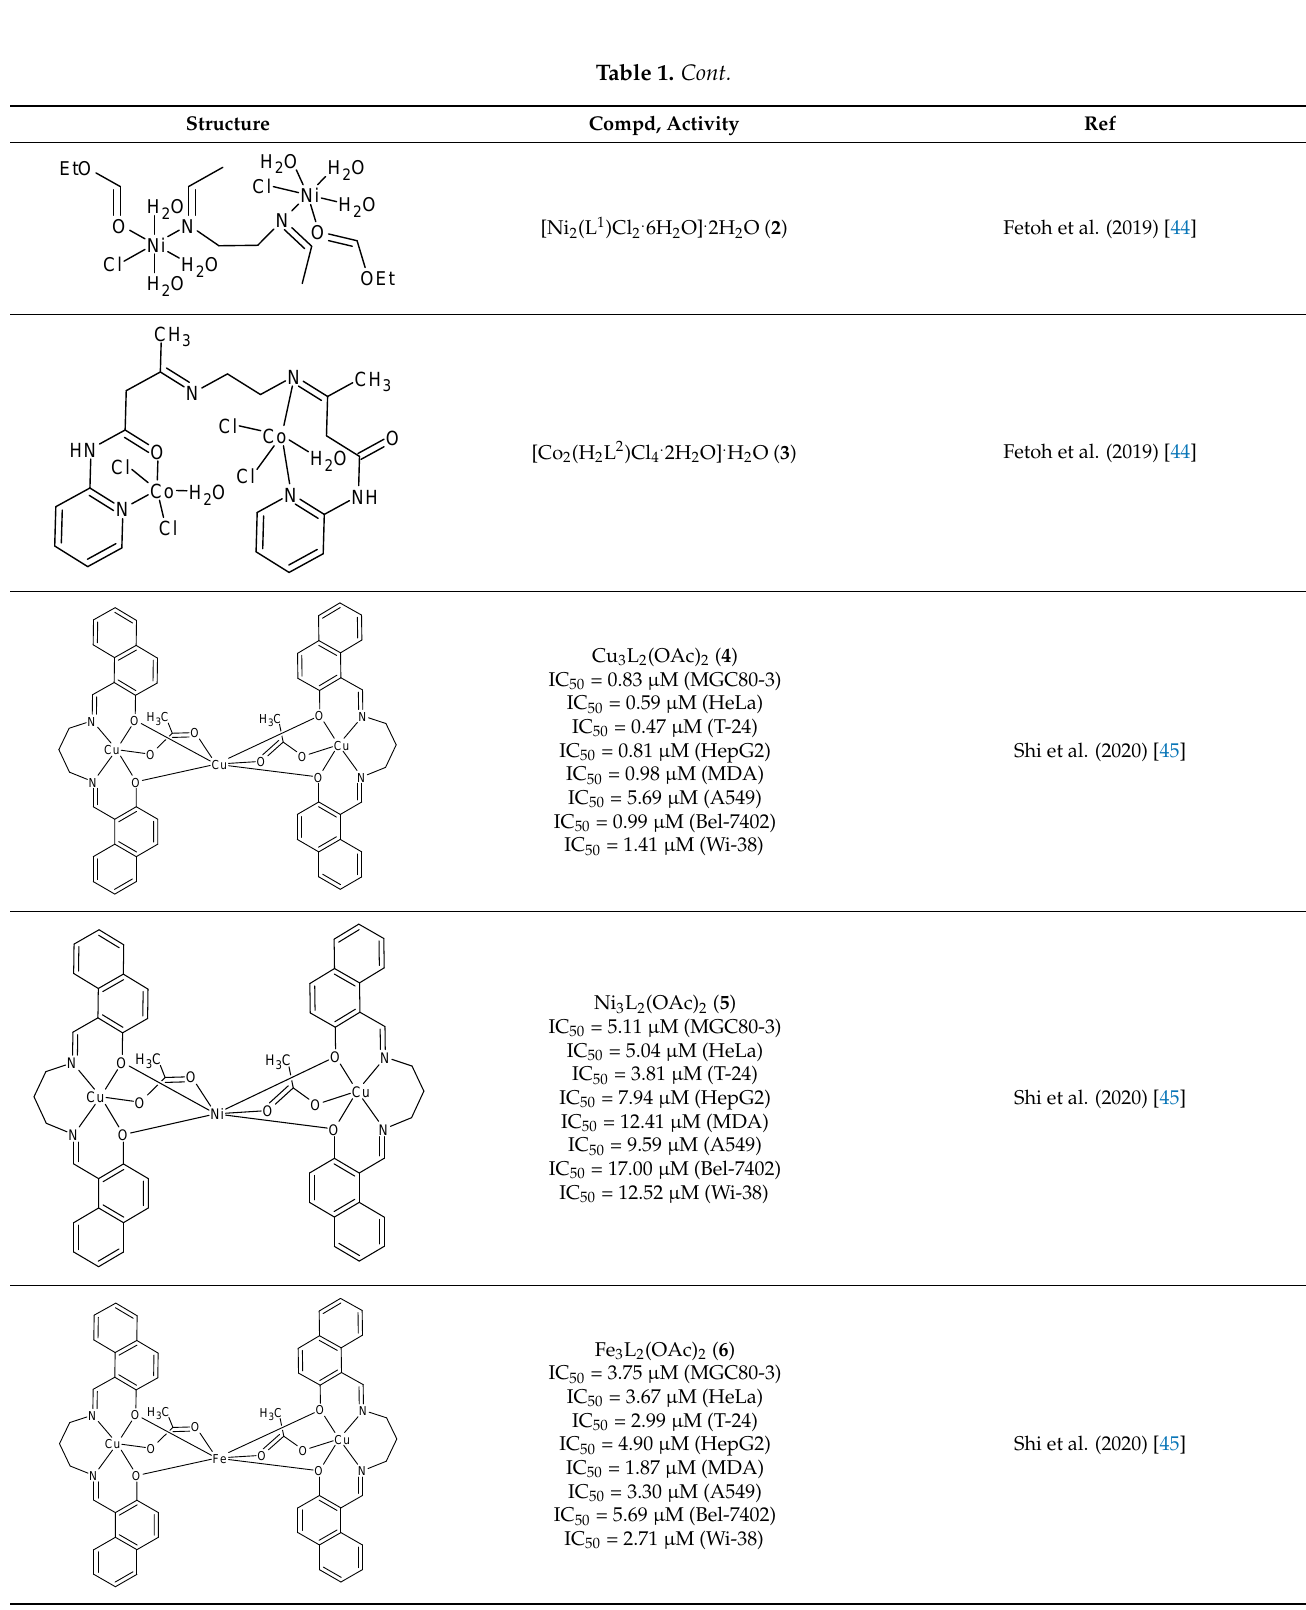
Table 1. Antiproliferative activity of Schiff base complexes with transition